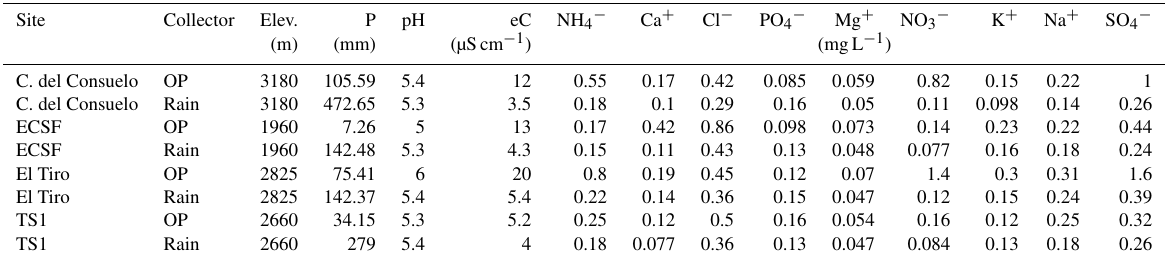
Table A1. The 6-year average ion concentration (2004–2009) in rain and OP, precipitation volume, and electrical conductivity at MSs along an altitudinal gradient in southern